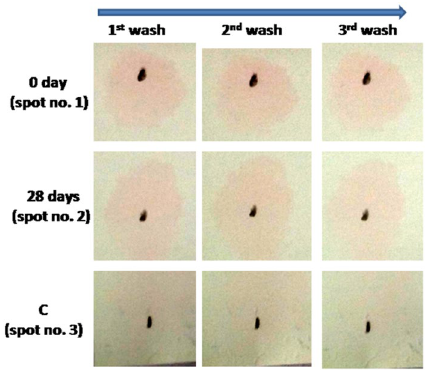
Figure 11. Time dependent interaction study of aptamer with PAG protein.